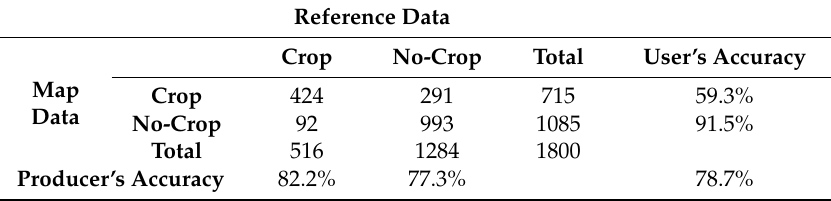
Table 8. The error matrix showing the overall accuracy of the GFSAD1km cropland extent map.